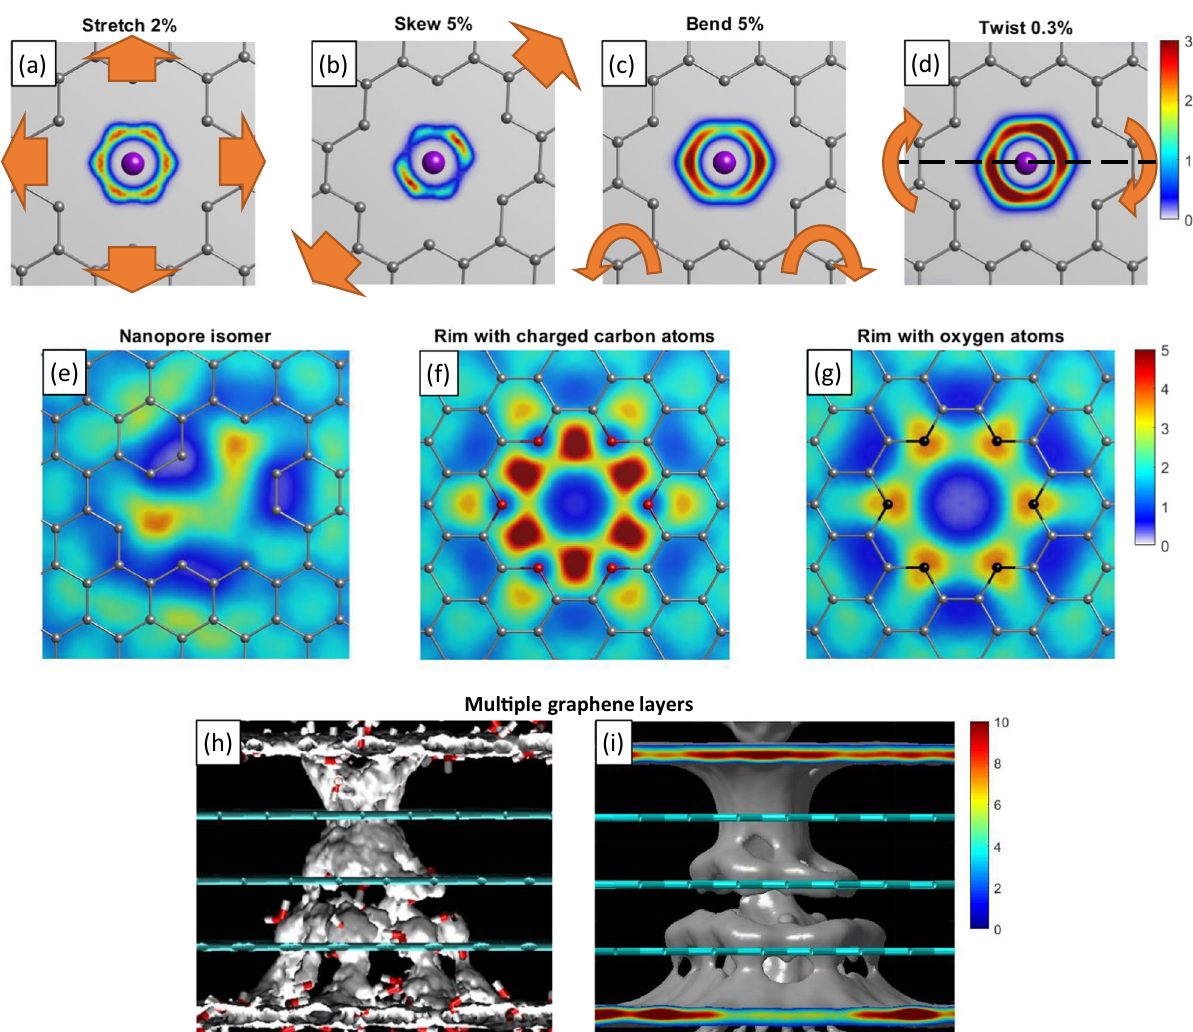
Fig. 4 Tools to control the hydration pattern. These include the extrinsic processes of: a stretching, b skewing or asymmetric stretching, c bending, d twisting, and the intrinsic features of — e choice of pore isomer, f charging of the rim atoms (red balls), g functionalising the rim with oxygen atoms (black balls), h use of a multi-layer pore, as exempli fi ed in a molecular dynamics simulation ( h adapted from ref. 61 , copyright 2019, with permission from Elsevier), and i theoretical prediction, Eq. (4). Density slices have been taken at Z = − 0.23 nm ( a ) – ( d ) and Z = − 0.28 nm ( e ) – ( g ). The graphene lattice is indicated in a grey ball-and-stick